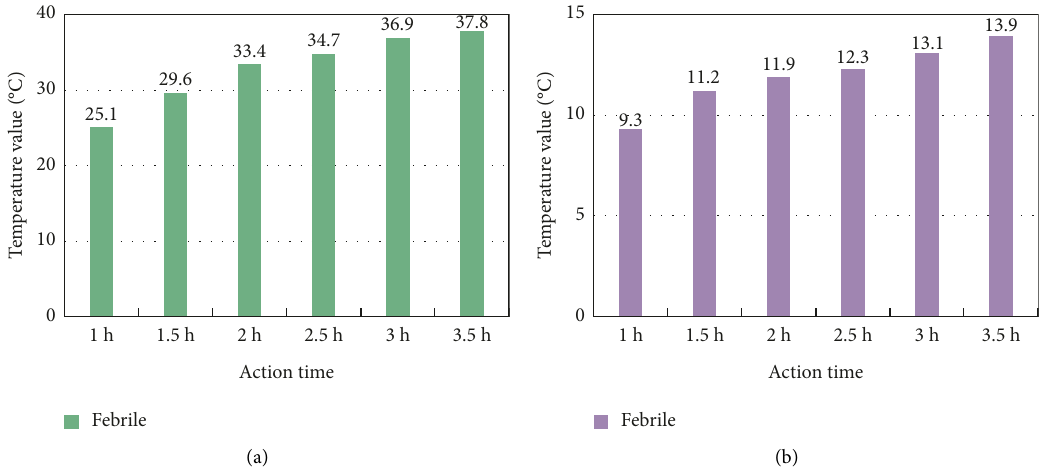
Figure 7: Study on clothing heating. (a) is the thermal conductivity temperature of clothing under graphene oxide material. (b) shows the thermal conductivity temperature of clothing under traditional design materials.